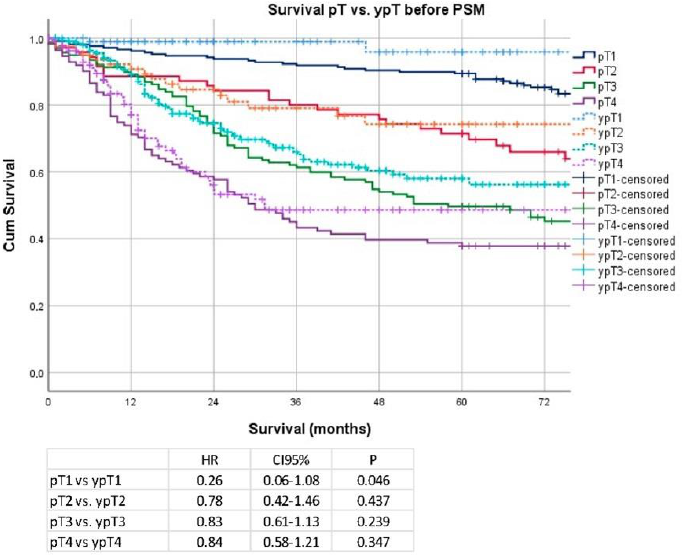
Figure 2. Kaplan – Meier analyses according to pT/ypT stages before propensity score matching Figure 2. Kaplan–Meier analyses according to pT/ypT stages before propensity score matching (PSM).